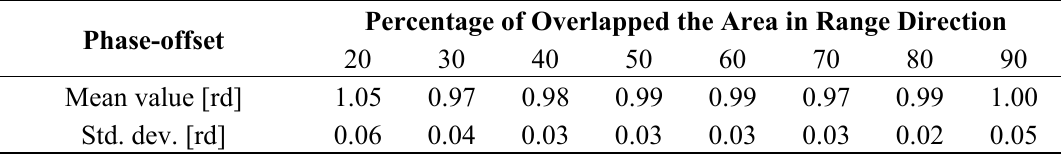
Table 1. Performance regarding the percentage of the area used in range